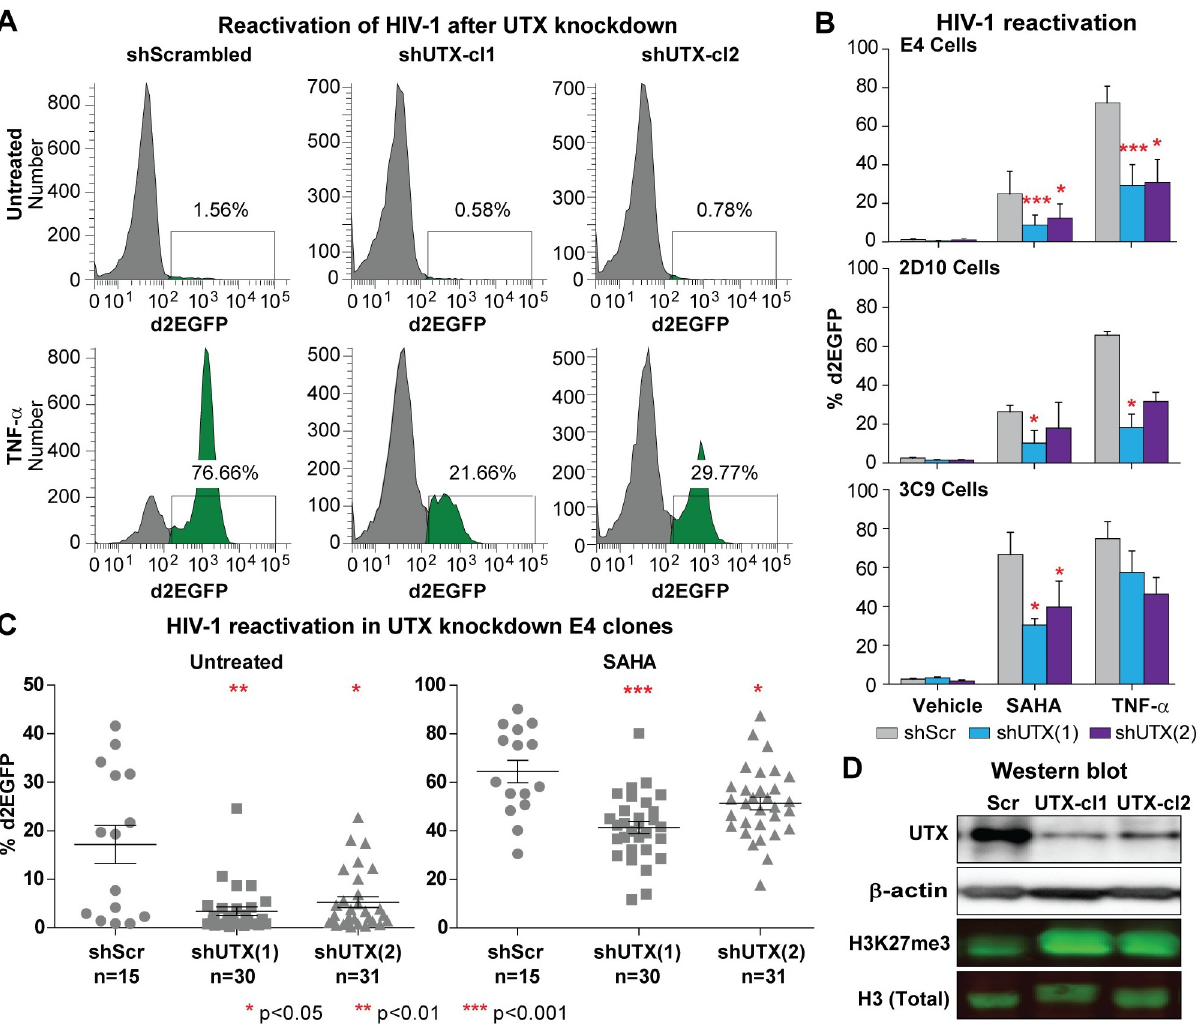
Fig 1. Inhibition of HIV-1 reactivation in UTX knocked down E4 cells. (A) Representative FACS measuring d2EGFP expression in two UTX knocked down clones from E4 cells stimulated with TNF- α (10 ng/ml) overnight. (B) Quantification of HIV-1 reactivation in two clones from UTX knocked down E4 cells, UTX knocked down 2D10, and UTX knocked down 3C9 cells stimulated with indicated conditions. 3C9 cells harbor Nef+, Wt Tat HIV, while 2D10 cells are infected with H13L mutant Tat HIV-1. Note that H13L Tat is a functional Tat, as it has been shown that we can easily reactivate HIV-1 in 2D10 cells by many different stimuli. Error bars: SEM of 3 separate experiments. (C) d2EGFP expression in UTX knocked down E4 clones left untreated or stimulated with SAHA (2 μ M) overnight. Kruskal-Wallis test was used for statistical calculation. (D) Western blot measuring the levels of UTX and H3K27me3 in E4 cells expressing scramble or UTX